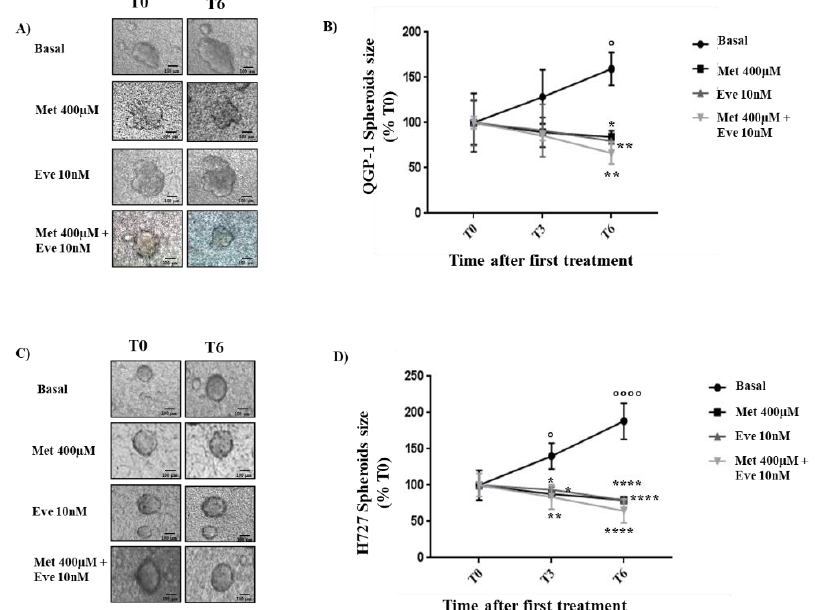
Figure 4. Metformin (Met) and everolimus (Eve) treatment on QGP-1 and H727 3D Spheroids. QGP-1 And H727 spheroids were performed using the BIOMIMESYS ® hydrosca ff old of crosslinked hyaluronic acid (HA) chains. Cells were followed by imaging using brightfield microscopy with a 4X objective lens (Widefield IX53 Inverted, Olympus). ( A , C ) Representative images of QGP-1 and H727 spheroids after their formation and after three and six days of treatment with metformin 400 µ M and everolimus (10nM), alone or in combination. 0 days: time point when treatments started (T0); 3 days and 6 days are the time points analyzed after the treatments started (T3–T6). Scale bar 100 µ m. ( B , D ) Growth of the 3D spheroids upon treatment with metformin and everolimus, alone or in combination . The area was measured using the software ImageJ. Experiments were repeated 2 times and each determination done in triplicate. Statistical analysis was performed with a two-way ANOVA test followed by Tukey’s post-hoc test. Values represent mean ( ± SD.) and are shown as a percentage of control at day 0. * = p < 0.05, ** = p < 0.01, **** = p < 0.0001 vs. T6 Basal. ◦ = p < 0.05 vs. T0 Basal, ◦◦◦◦ = p < 0.0001 vs. T0 Basal.